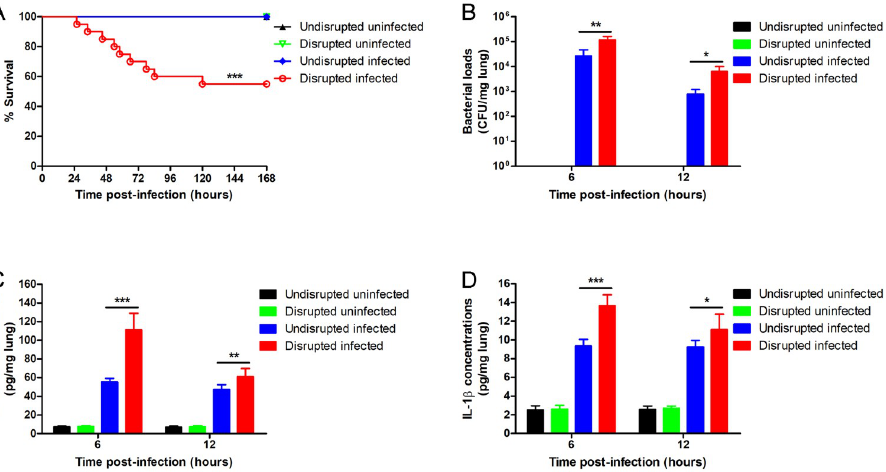
Fig 1. Gut microbiota disruption decreases the pulmonary resistance to S . pneumoniae . Wild-type mice were given broad-spectrum antibiotics or autoclaved saline. Three days after cessation of administration, mice were inoculated intra-nasally with 2.3 × 10 8 CFU of S . pneumoniae . (A) The survival was observed for 7 days (n = 20 per group). (B) Bacterial load, and (C) TNF- α and (D) IL-1 β concentration per mg lung tissue were determined 6 hours and 12 hours after infection (n = 6 per group). CFU, colony-forming units. Data are presented as means ± SD. � P < 0.05, �� P < 0.01, ��� P < 0.001, analyzed with the log-rank test or unpaired Student’s t